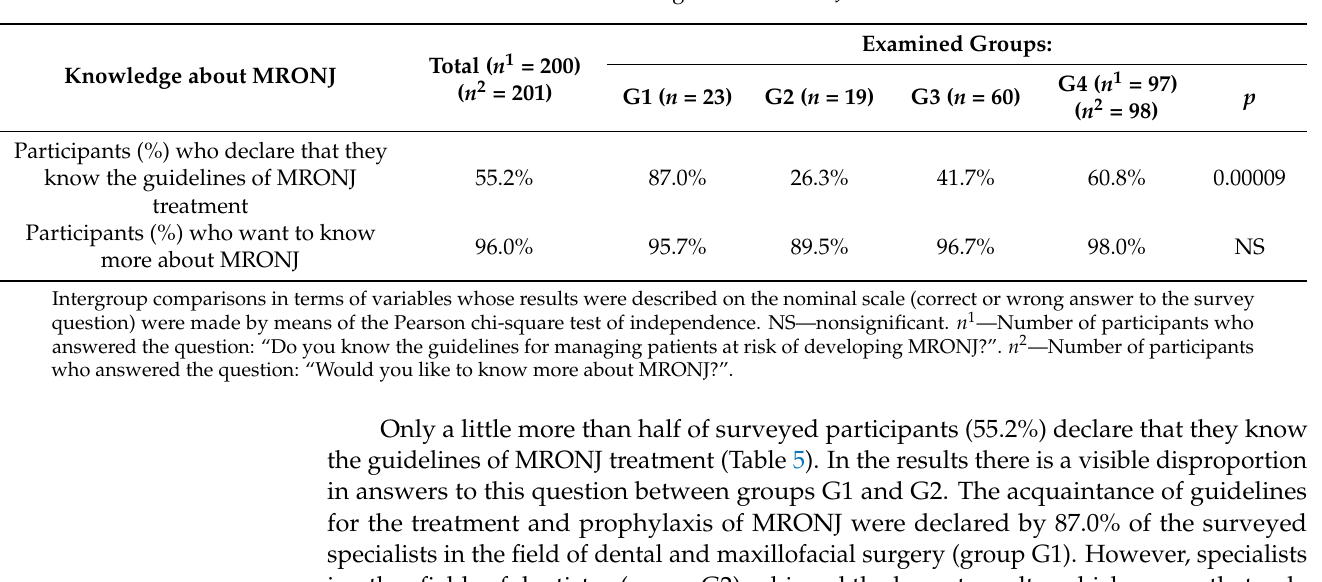
Table 5. The knowledge about